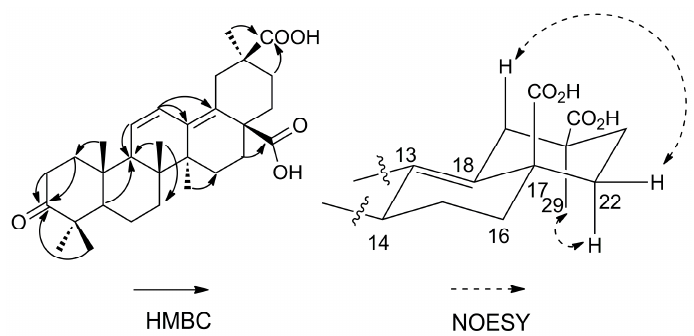
Figure 2. Key HMBC (Heteronuclear Multiple Bond Correlation, From H to C) and NOESY (Nuclear Overhauser Effect Spectroscopy, From H to H) correlations for 1.